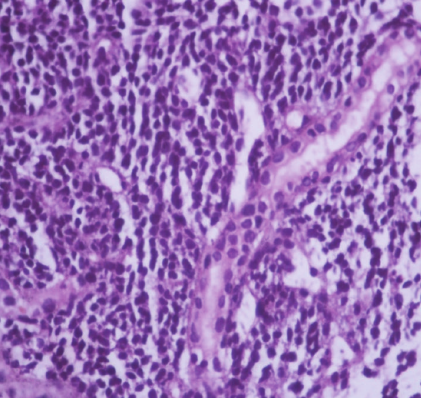
Figure 3: High power view shows entrapped normal renal tubules.